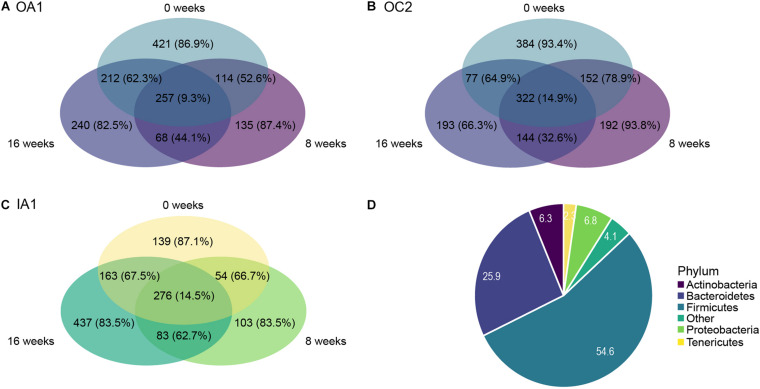
Venn diagrams of each poultry house [(A) OA1; (B) OC2; (C) IA1] showing the number of ASVs shared across all timepoints or unique to a single sampling time. Poultry house IB2 was excluded. Number of ASVs are shown for each compartment, and the percentage of rare taxa (ASVs with relative abundance of < 0.01%) are shown in parentheses. (D) Relative abundances (%) of five most abundant phyla within the subset of rare ASVs (relative abundance < 0.01% across all samples).